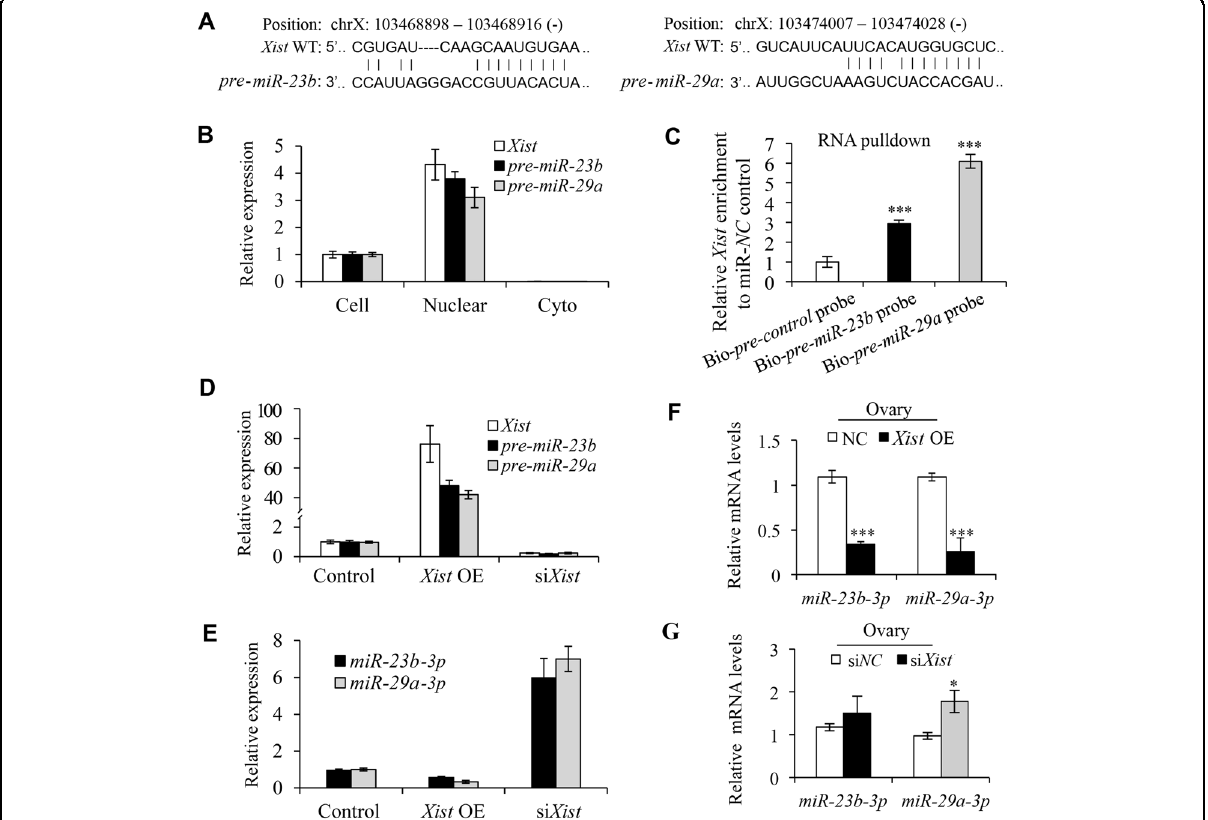
Fig. 3 Xist regulates miR-23b and miR-29a maturation process. a The predicted pre-miR-23b and pre-miR-29a binding sites in the Xist transcript. b qRT-PCR analysis of Xist, pre-miR-23b, and pre-miR-29a expression in nuclear and cytoplasmic fraction relative to the whole cells from 0.5 dpp ovaries. c Enrichment of Xist pulled down by biotin- pre-miR-23b , biotin- pre-miR-29a , or biotin- pre-miR-NC control in the nuclear fraction from 3T3 cells. d qRT- PCR analysis of Xist, pre-miR-23b, and pre-miR-29a expression in Xist overexpression or Xist knockdown 3T3 cells. e qRT-PCR analysis of miR-23b-3p, and miR-29a-3p expression in Xist overexpression or Xist knockdown 3T3 cells. f , g Relative levels of miR-23b-3p and miR-29a-3p in cultured newborn ovaries transfected with Xist or empty control ( f ), and in ovaries transfected with si Xist or scrambled control ( g ). Student ’ s t -test: * P < 0.05, *** P <